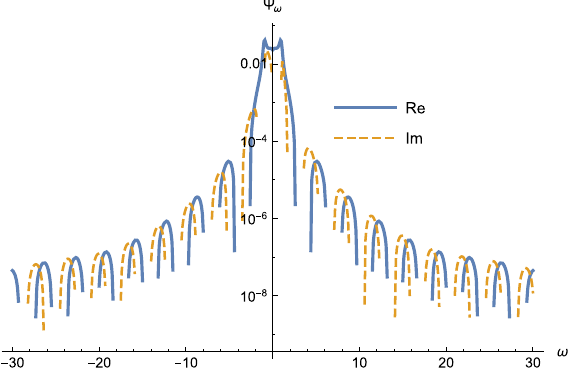
x = 4 . Right: The calculated time series of the massless scalar pertur- 21 bations. The calculations are carried out to generate a total of 40 points in the time